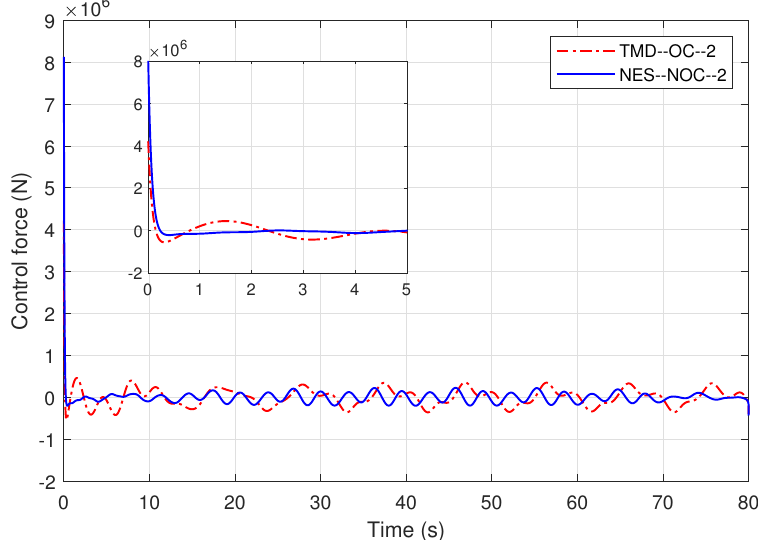
Figure 18. Control force by TMD–OC–2 and